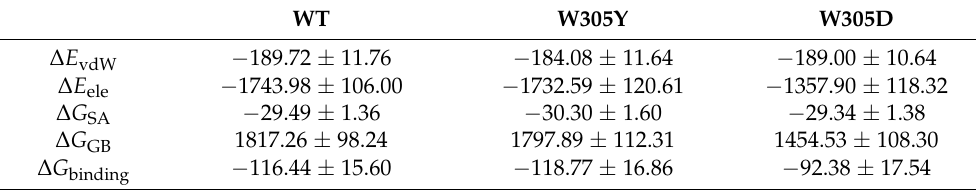
Table 1. Binding free energy (kcal/mol) between the different DAPK1 states and